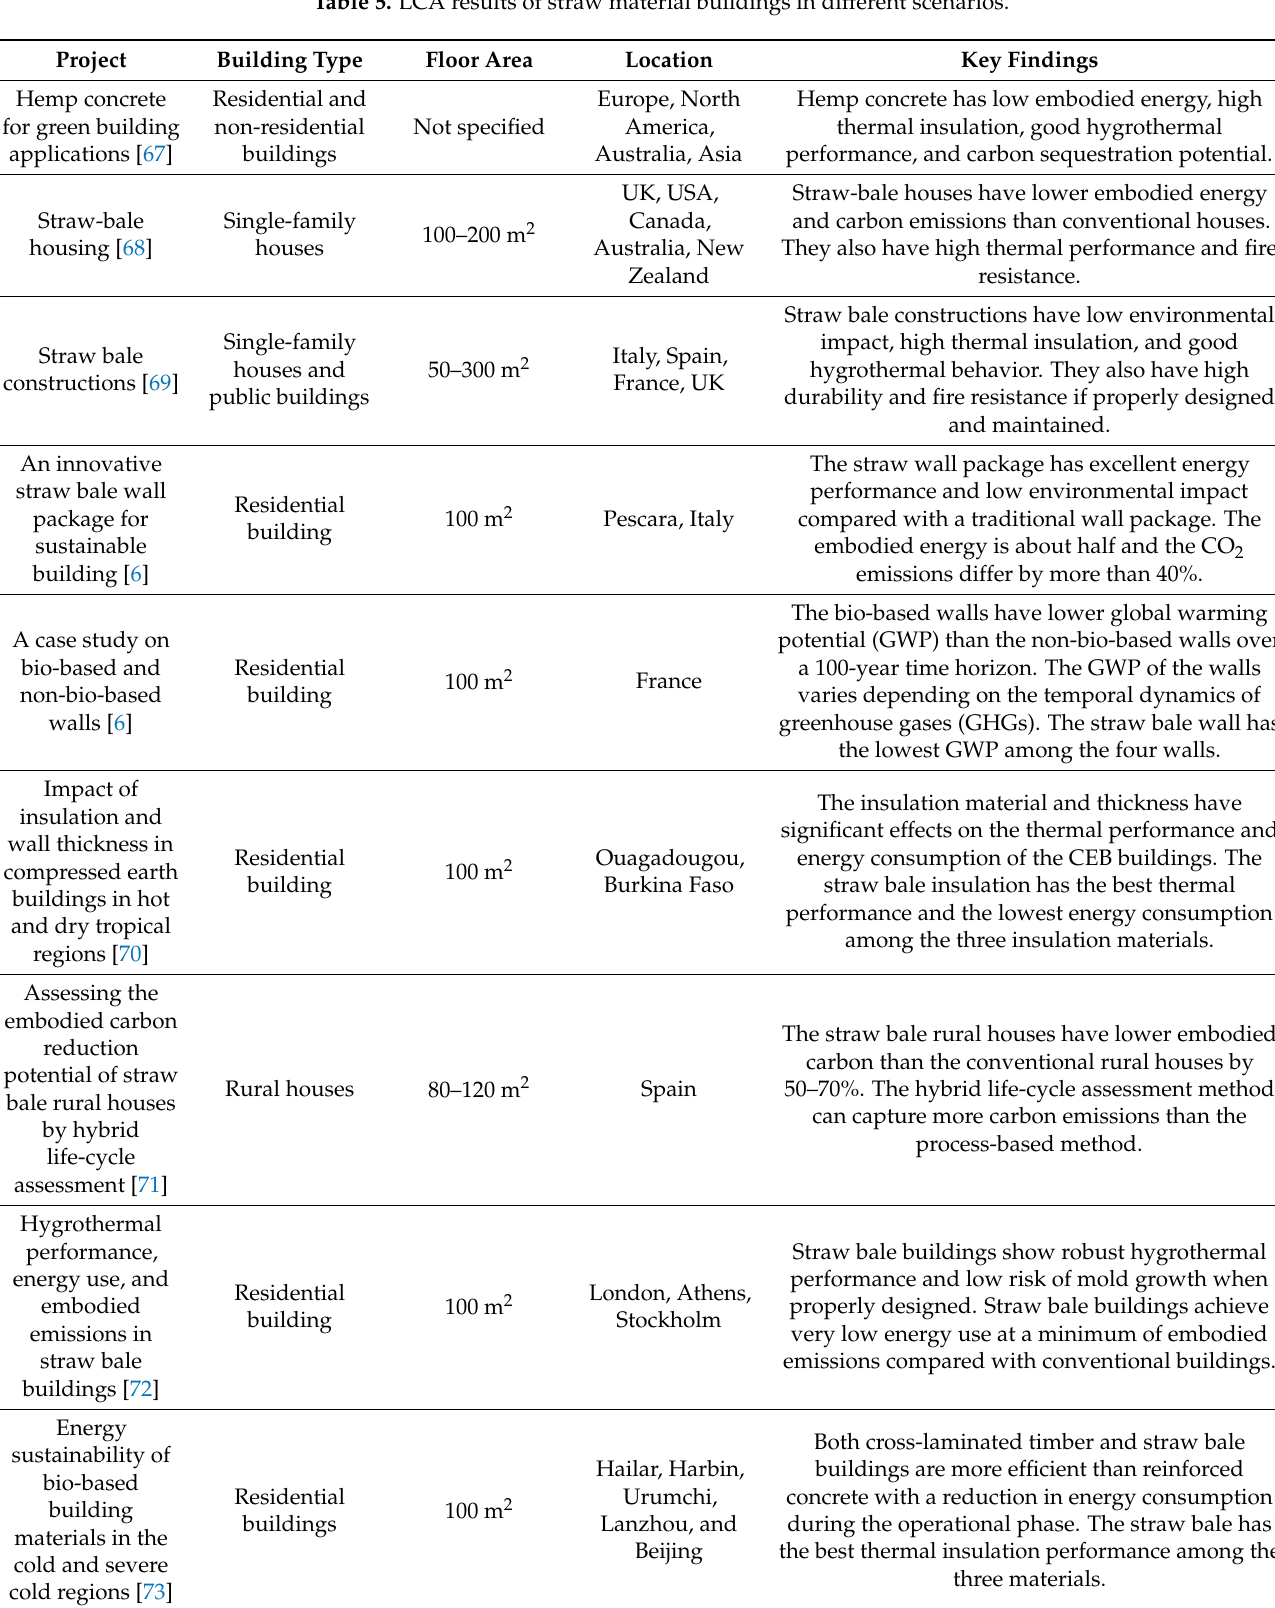
Table 5. LCA results of straw material buildings in different